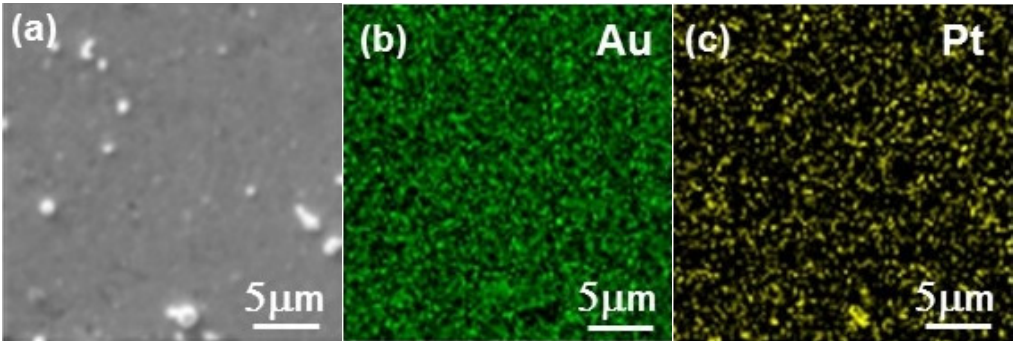
Figure 6. I-t curves recorded at OCV during the Pt replacement of Te layer for various numbers of replacements.